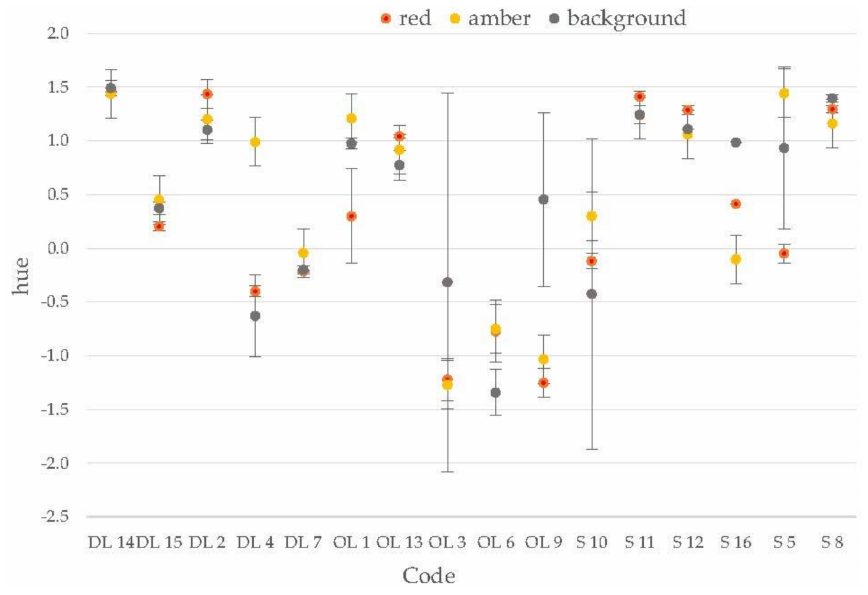
Figure 9. Average of hue values per color for all the